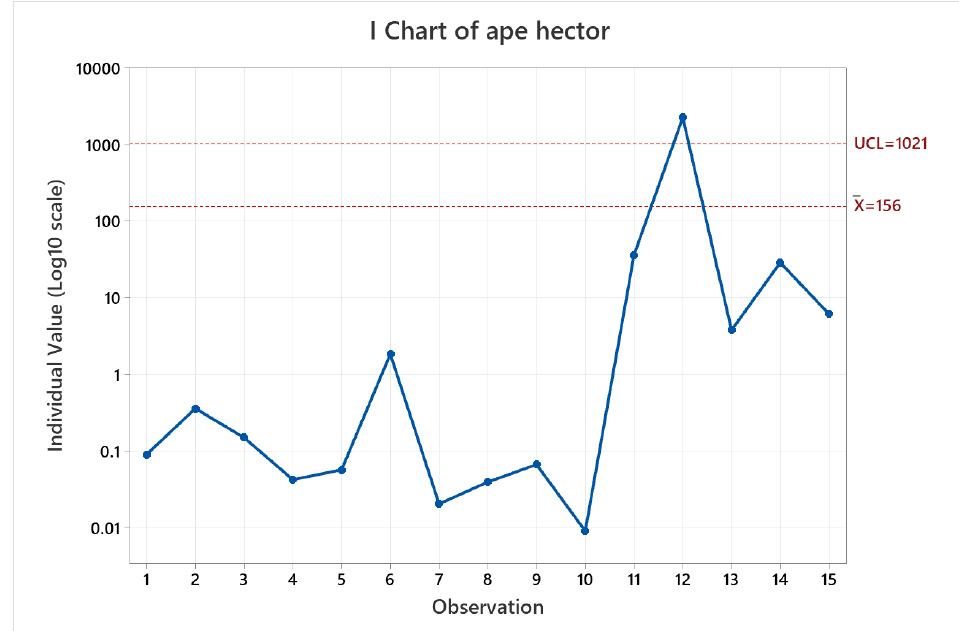
Figure 19. Pose accuracy mean behavior for HECTOR-SLAM.